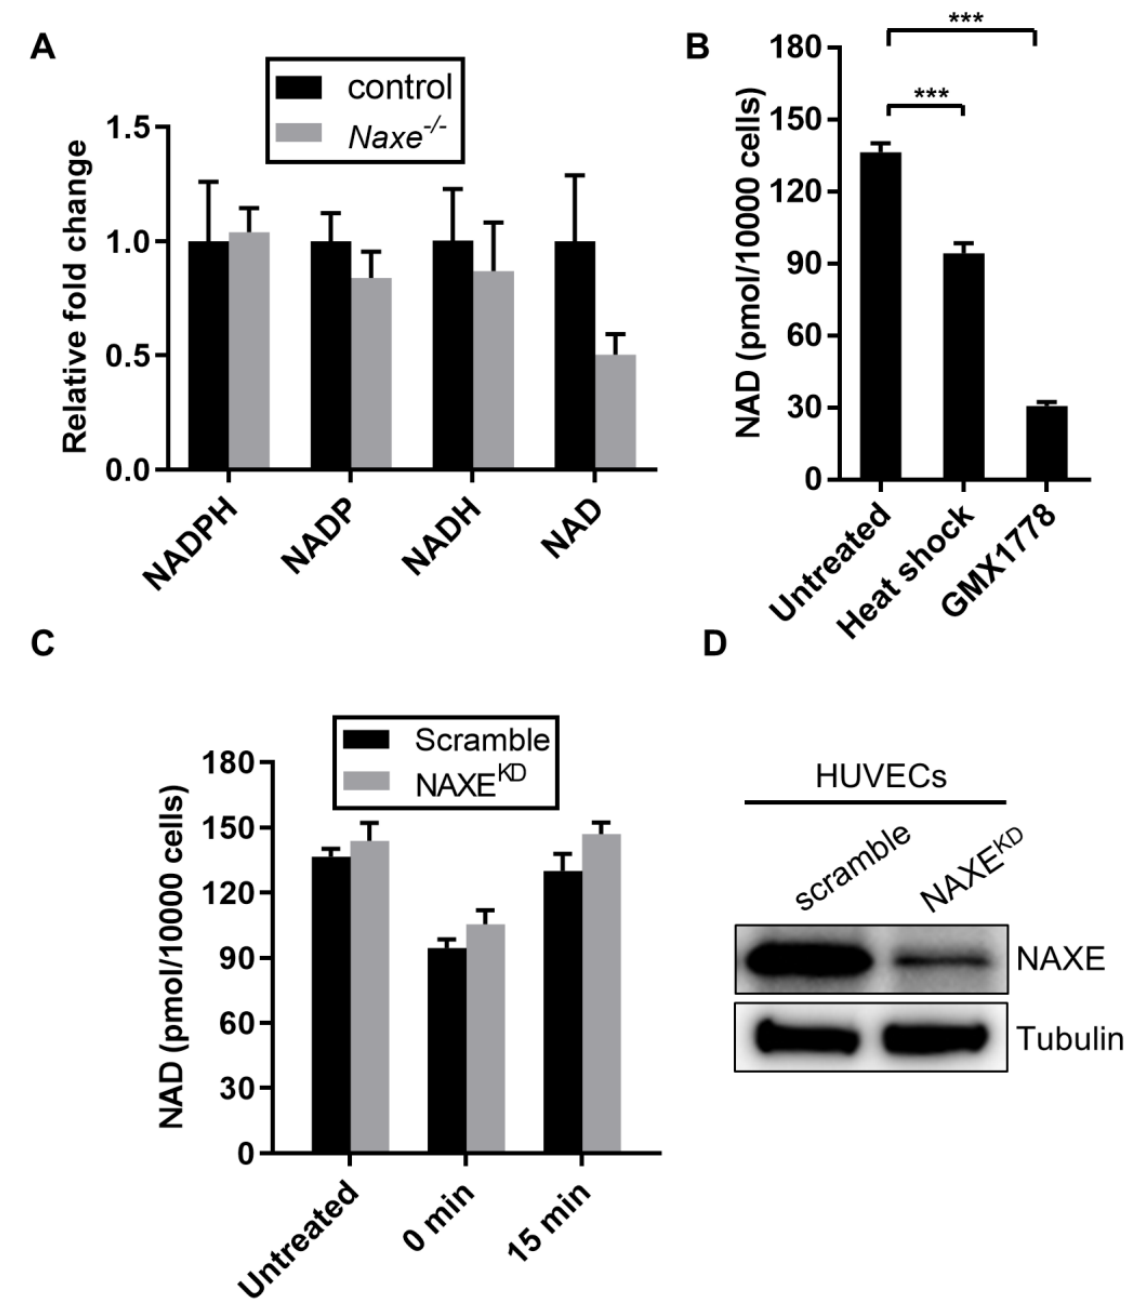
Figure 3. Effect of NAXE deficiency on NAD(P) and NAD(P)H abundance. ( A ) Relative abundance of NAD(P) or NAD(P)H in control or Naxe − / − cardiac tissue. ( B ) HUVECs plated in a 96-well microplate were subjected to heat shock (1 h at 45 ◦ C) or to overnight GMX1778 treatment (positive control) to induce NADH damage, and total NAD levels were measured. GMX1778 is an inhibitor of nicotinamide phosphoribosyltransferase. ( C ) HUVECs were transfected with NAXE siRNA or scramble control siRNA and subjected to heat shock as in B and allowed to recover for indicated times, and total NAD levels were measured. ( D ) NAXE knockdown was verified using Western blot. Mean ± SE; *** p < 0.001; n = 6.